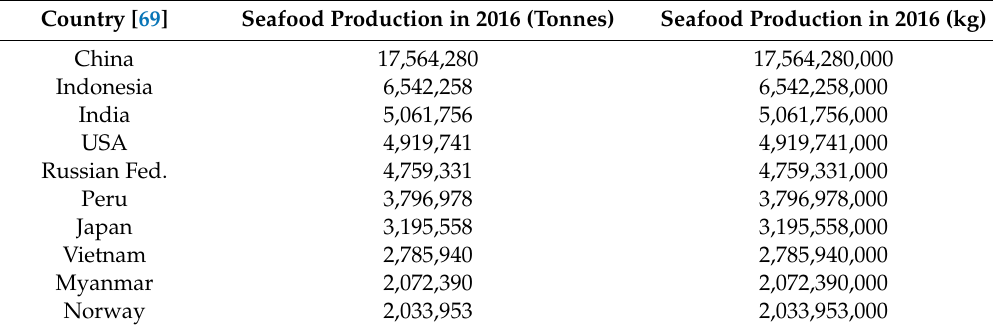
Table 3. Annual seafood production by the top 10 countries in 2016.